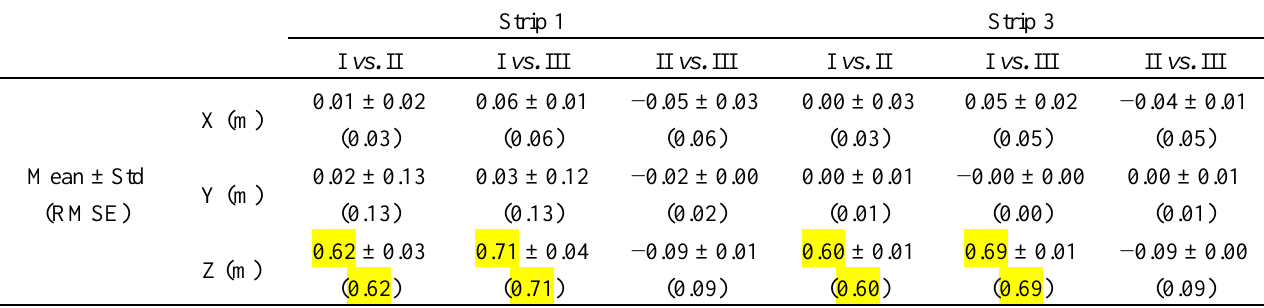
Table 7. RMSE equivalency analysis for the three configuration cases (Quasi-rigorous